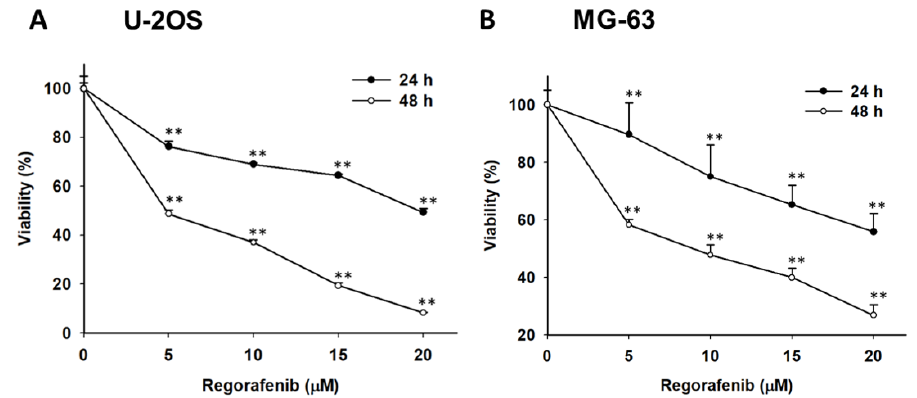
Figure 1. The viability of human osteosarcoma cells was reduced by regorafenib. ( A ) U-2 OS cells and ( B ) MG-63 cells were treated with 0, 5, 10, 15, 20 µM of regorafenib for 24 h or 48 h. The viability of U-2 OS cells and MG-63 cells were both evaluated by 3-(4,5-Dimethylthiazol-2-yl)-2,5-diphenyltetrazolium bromide (MTT) assay. * p < 0.05 and ** p < 0.01 vs. 0 µM of regorafenib.